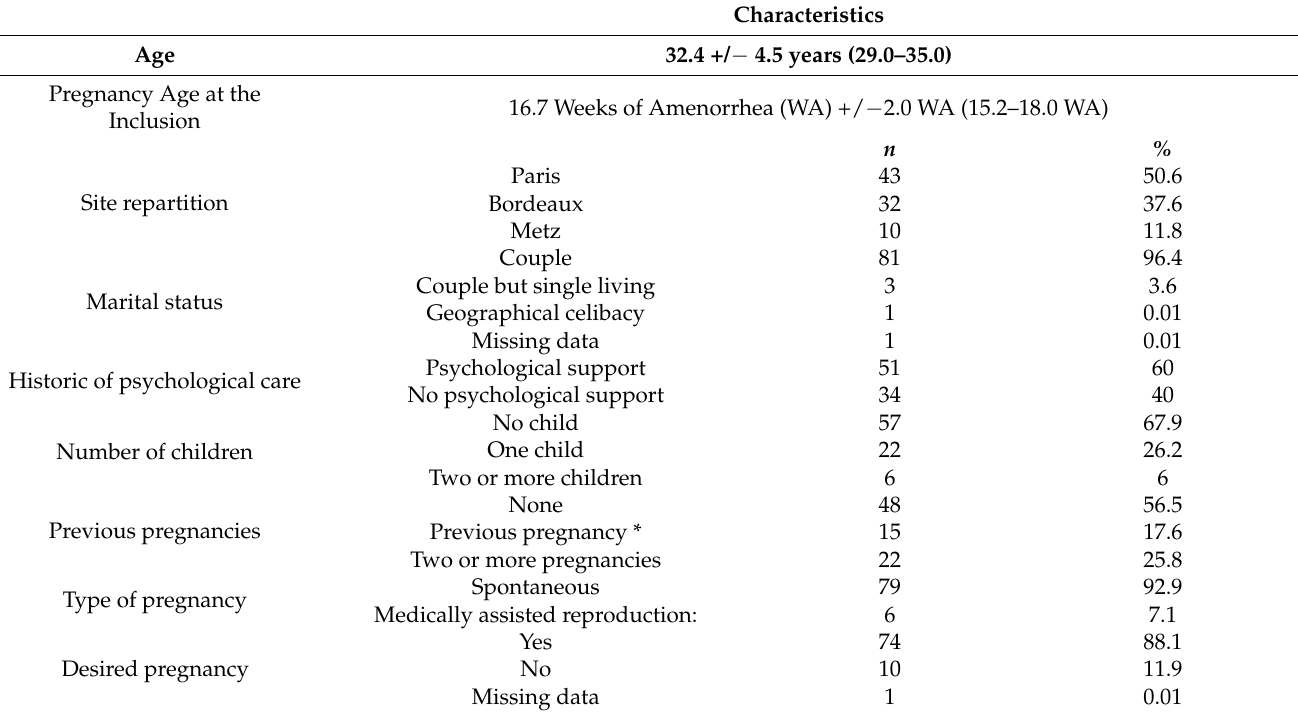
Table 3. Summary of the socio demographic data of the initial cohort.